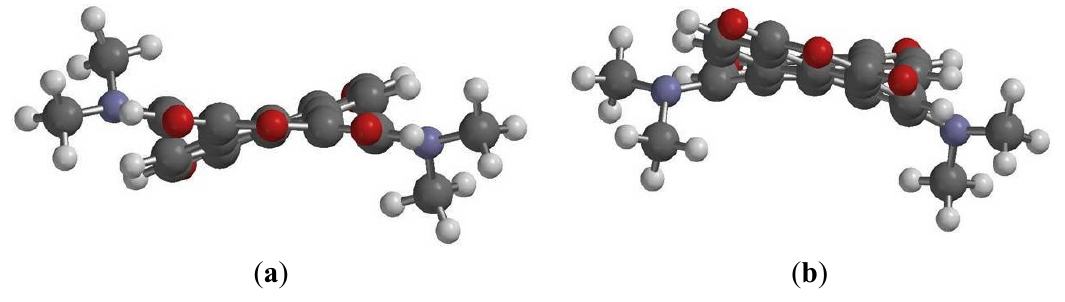
Figure 8. DFT (B3LYP/6-31G**) geometry-optimized structures of 1a ( b ); and 2a ( a ) shown with view along the long axis. Methyl groups replace the hexyl groups for